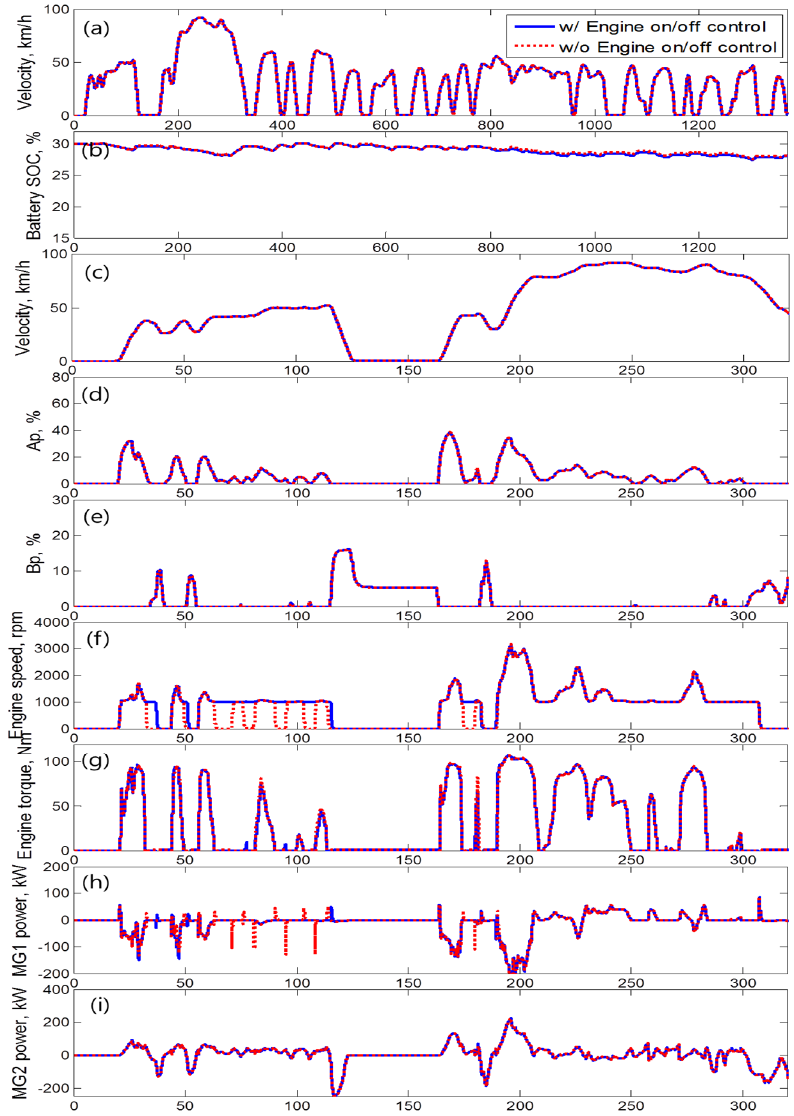
Figure 12. Simulation results of the cautious driver (Driver 7) for engine on/off control. ( a ) velocity; ( b ) battery SOC; ( c ) velocity; ( d ) Ap; ( e ) Bp; ( f ) engine speed; ( g ) engine torque; ( h ) MG1 power; ( i ) MG2 power.